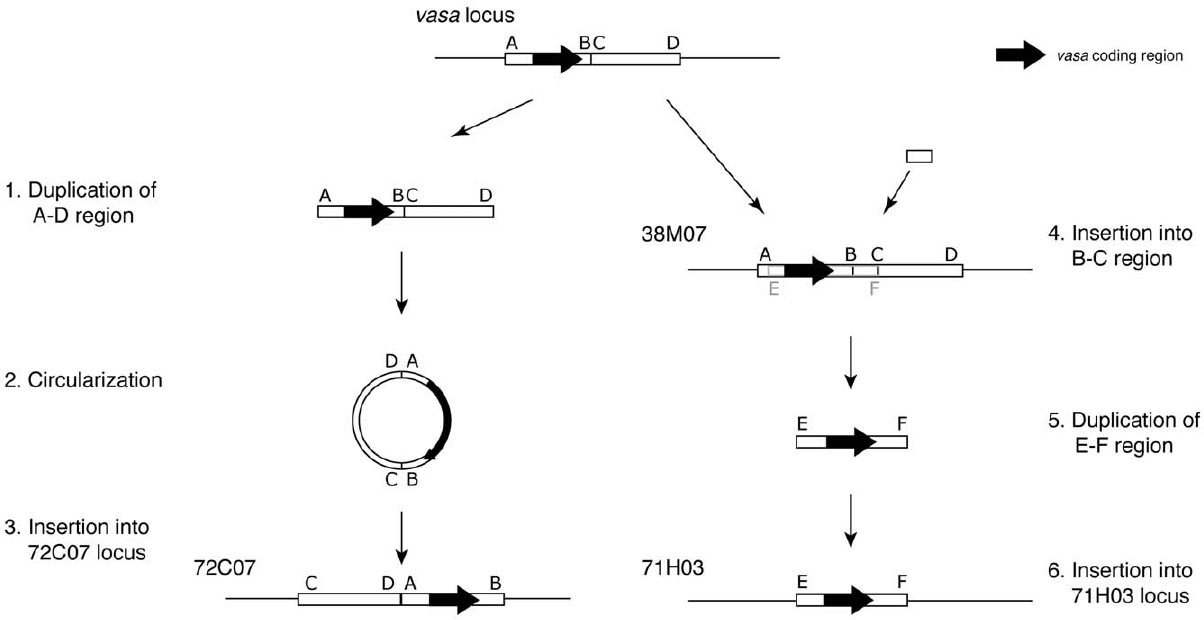
Figure 7. A model for the duplication of a Nile tilapia vasa gene. Duplications of the vasa gene occurred twice during the recent evolution of the genus Oreochromis . We speculated that the B–C region was inserted into 38M07 shortly after the duplication of 72C07. A circular DNA intermediate, which is recently recognized as a new mechanism to explain gene duplication, can explain the generation of a novel arrangement on clone 72C07. On the other hand, we have no evidence that the vasa gene in clone 71H03 was duplicated via a circular intermediate. Black arrow indicates the coding region of vasa gene. Boxes A–B, C–D, and E–F correspond to those of Figures 5, 8, S3, S4 and S5.